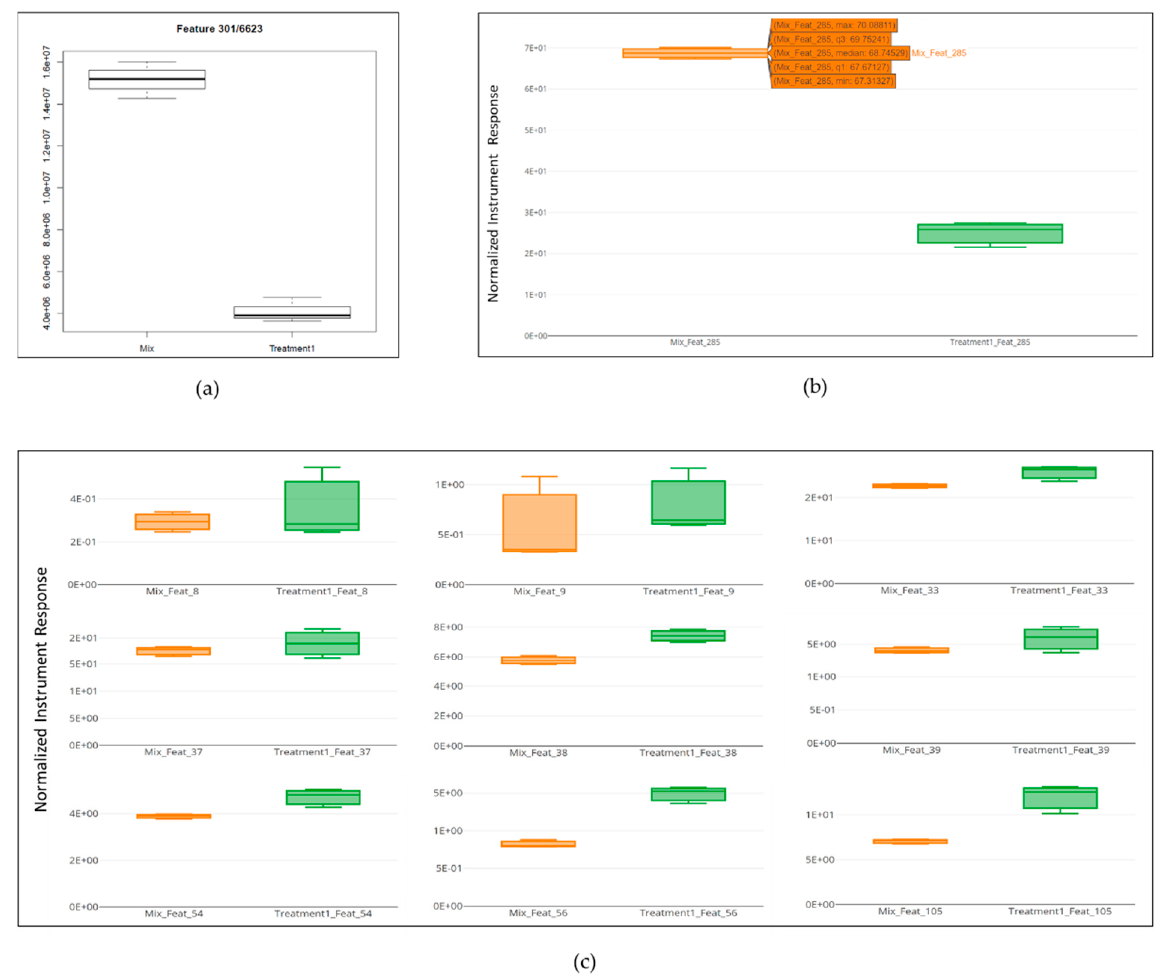
Figure 4. Box plots: ( a ) XCMS Online; ( b ) MStractor individual box plot with source data displayed upon hovering; ( c ) MStractor group box plots.